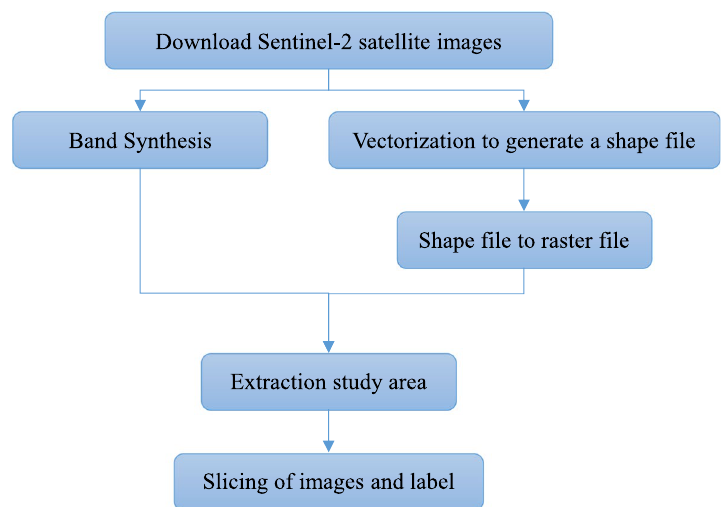
Fig. 2 Data preprocessing and various